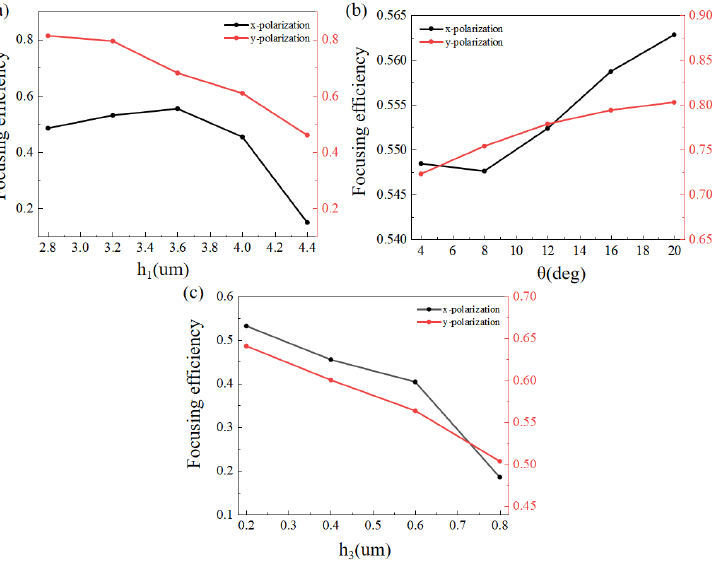
Figure 6. The Focusing efficiency of GaAs nano-bricks with ( a ) different height ( h 1 ), ( b ) inclination angle ( θ ) and ( c ) elliptic hemisphere height ( h 3 ) under x - and y -polarizations.